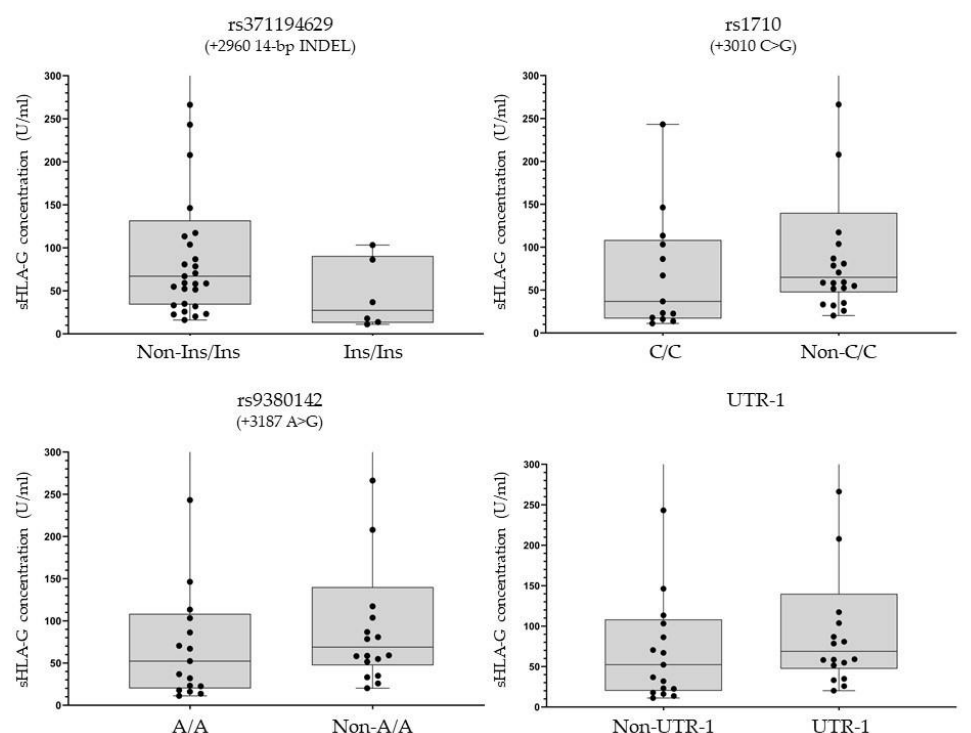
Figure 2. Plasma levels of sHLA-G according to the HLA-G 3′ UTR genotypes related to the main HLA-G 3′ UTR polymorphisms. The line represents the median value of sHLA-G levels, the grey box the 1st and 3rd quartile values in all the 35 plasma samples analyzed. The group name for rs371194629 refers to patients with Ins/Ins genotype (Ins/Ins) or Ins/Del and Del/Del genotypes (Non-Ins/Ins); for rs1710 to patients with C/C genotype (C/C) or C/G and G/G genotypes (Non-C/C); for rs9380142 to patients with A/A genotype (A/A) or A/G and G/G genotypes (Non-A/A); for UTR-1 haplotype to patients with almost one UTR-1 haplotype (UTR-1) or absence of UTR-1 haplotype (Non-UTR-1).